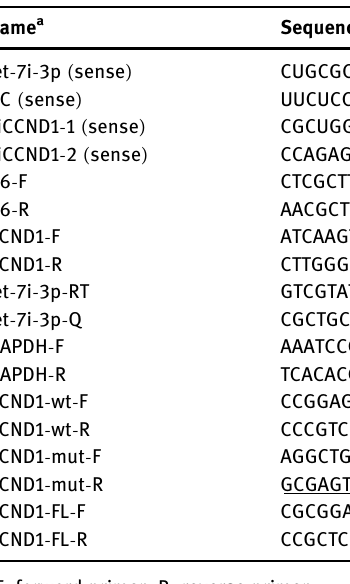
Table 1: Oligonucleotide